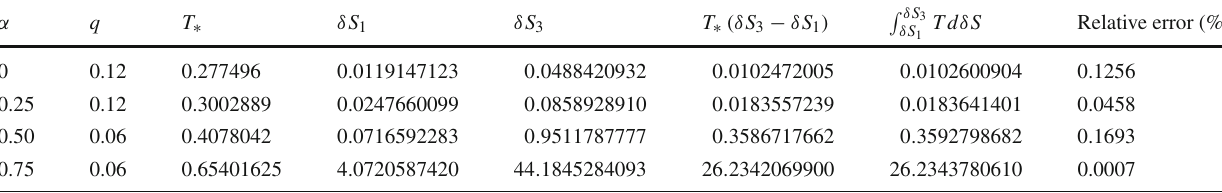
Fig. 10 T vs. δ S for n = 4 ,θ 0 = 0 . 3. a α = 0 , q = 0 . 12, b α = 0 . 25 , q = 0 . 12, c α = 0 . 5 , q = 0 . 06, d α = 0 . 75 , q = 0 . 06 Table 5 Numerical check of equal area law in T – δ S graph for n = 3 ,θ 0 = 0 . 2 , l = 1 , b = 1 , k = 1